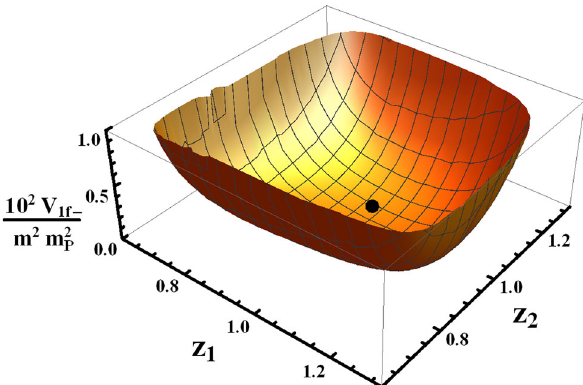
Fig. 5 The (dimensionless) SUGRA potential V f − / m 2 m 2 as a function of z 1 and z 2 for ¯ z 1 = ¯ z 2 = 0 – see Eq. (17) – and the inputs shown in column F of Table 1. The location of the dS vacuum in Eq. (26b) is also depicted by a thick black